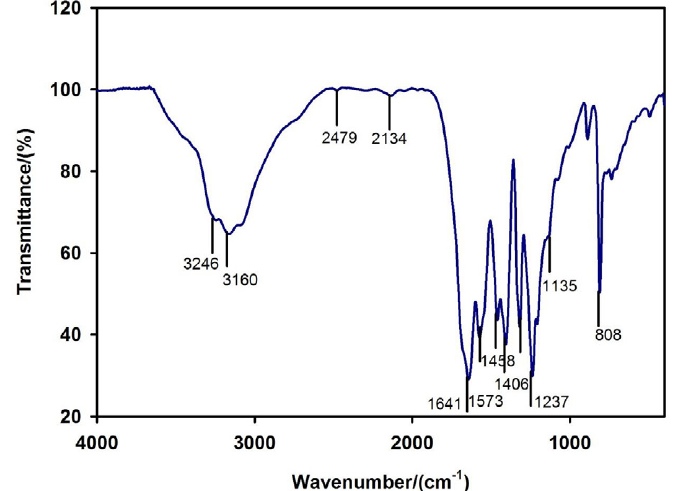
Fig.1. FTIR spectrum of g-C Fig.1- FTIR spectrum of g-C 3 N 4